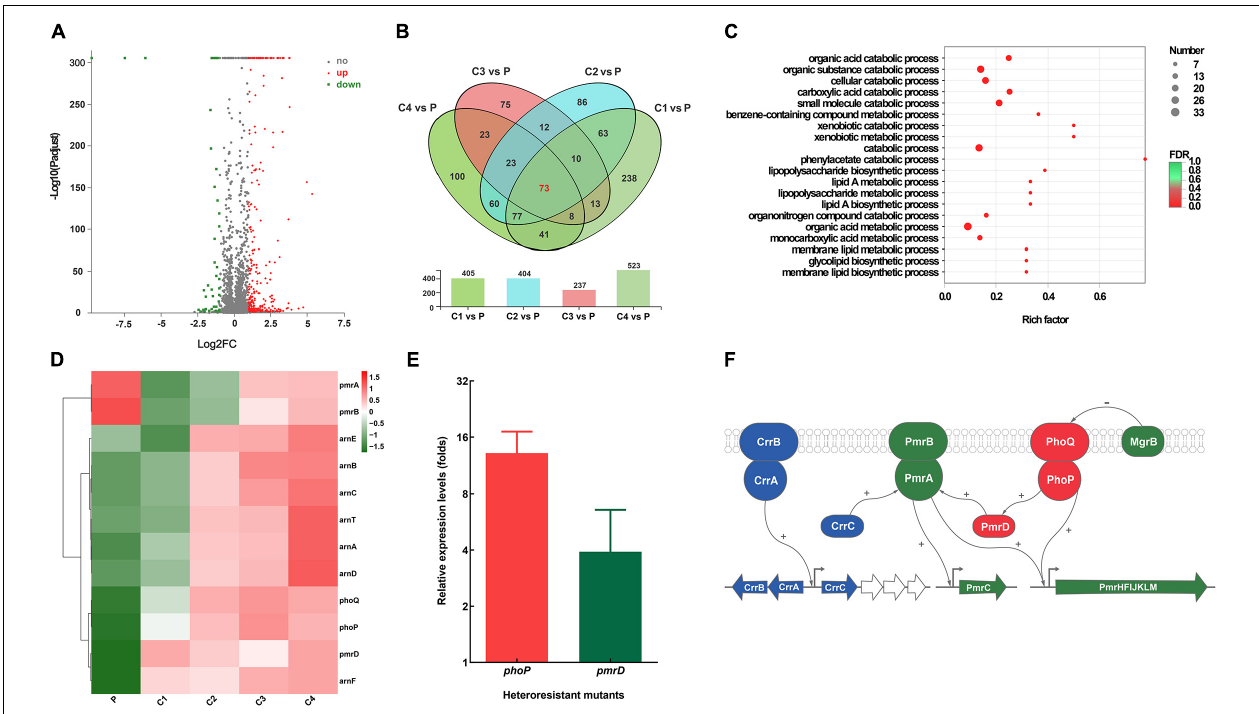
FIGURE 4 | Comparative transcriptomic analysis between K65 (P) and four resistant clones (C1–C4). (A) Volcano plot showing upregulated (designated red square) and downregulated (designated green square) genes of the resistant clones. (B) Venn diagram of the differentially expressed genes obtained from the four resistant clones. (C) Gene Ontology (GO) enrichment analysis of differentially expressed genes. (D) Heat map clustering of differential expression of key genes associated with colistin resistance. (E) Relative expression of phoP and pmrD in colistin-resistant subpopulations. (F) Model of colistin resistance